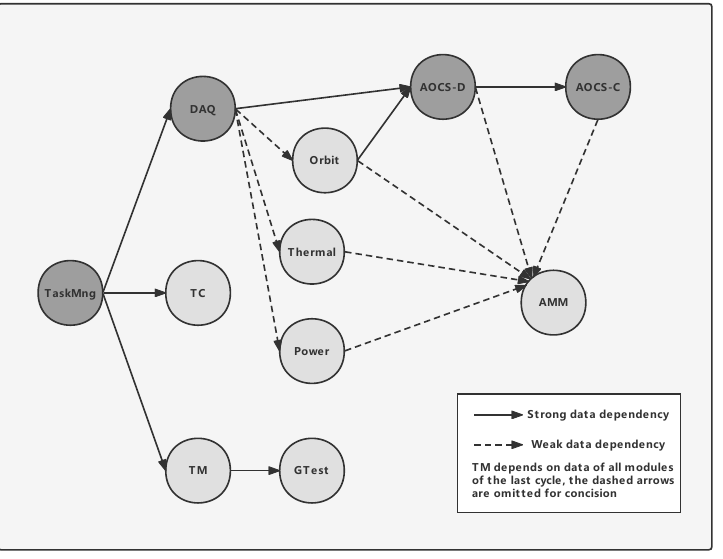
Figure 8. Module data dependency.